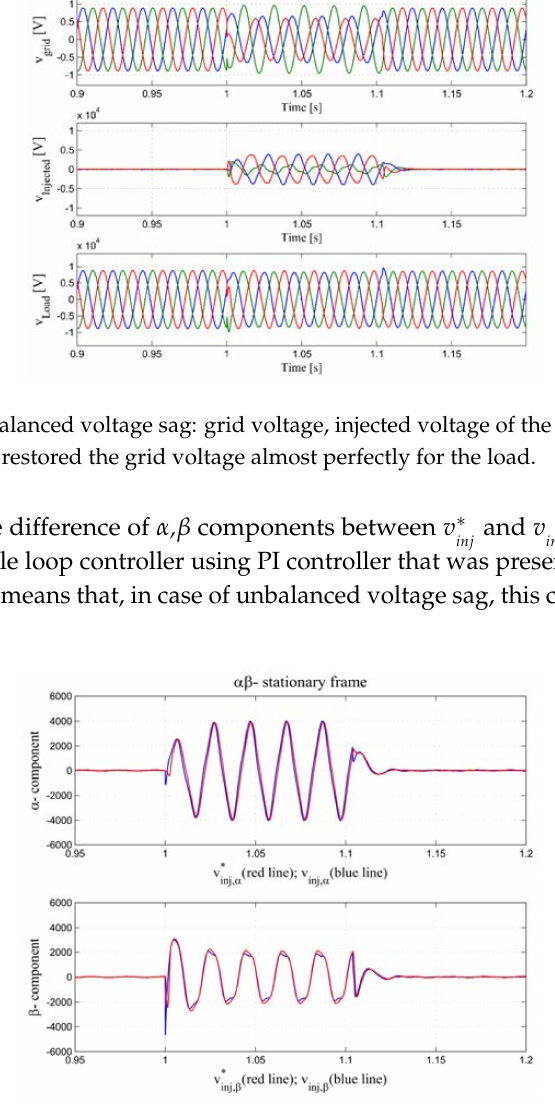
and v in stationary inj inj